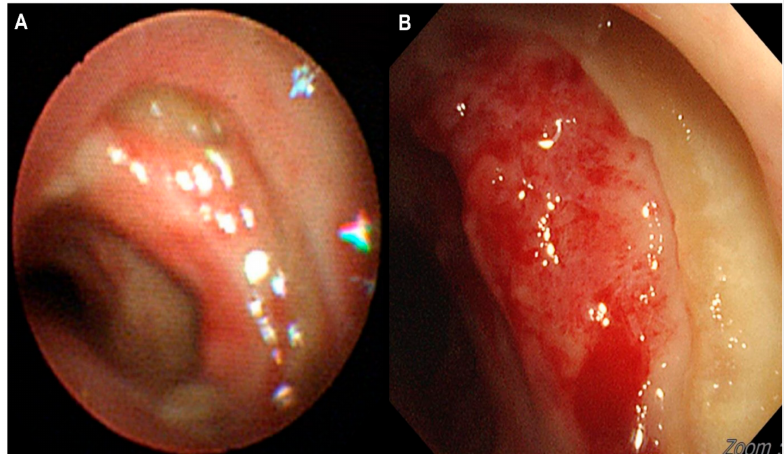
Figure 3. Bronchoscopic images. ( A ) Multiple deep ulcerations are noted in the proximal trachea. ( B ) Multiple biopsies were performed at the ulcer base and elevated ulcer margin.